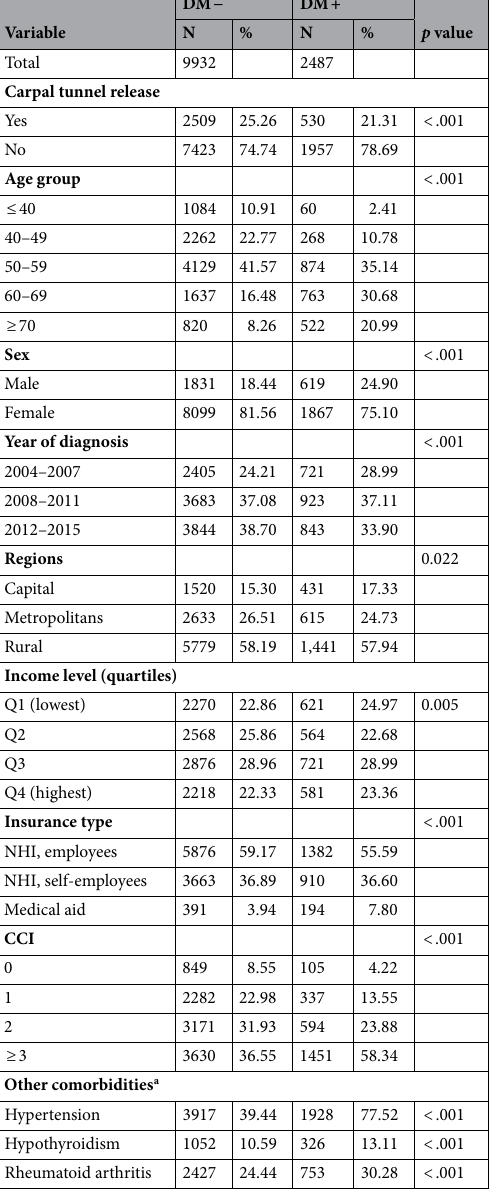
Table 1. Characteristics of the Study Populations with carpal tunnel syndrome (N = 12,419) according to presence of diabetes mellitus. DM: diabetes mellitus; NHI: National Health